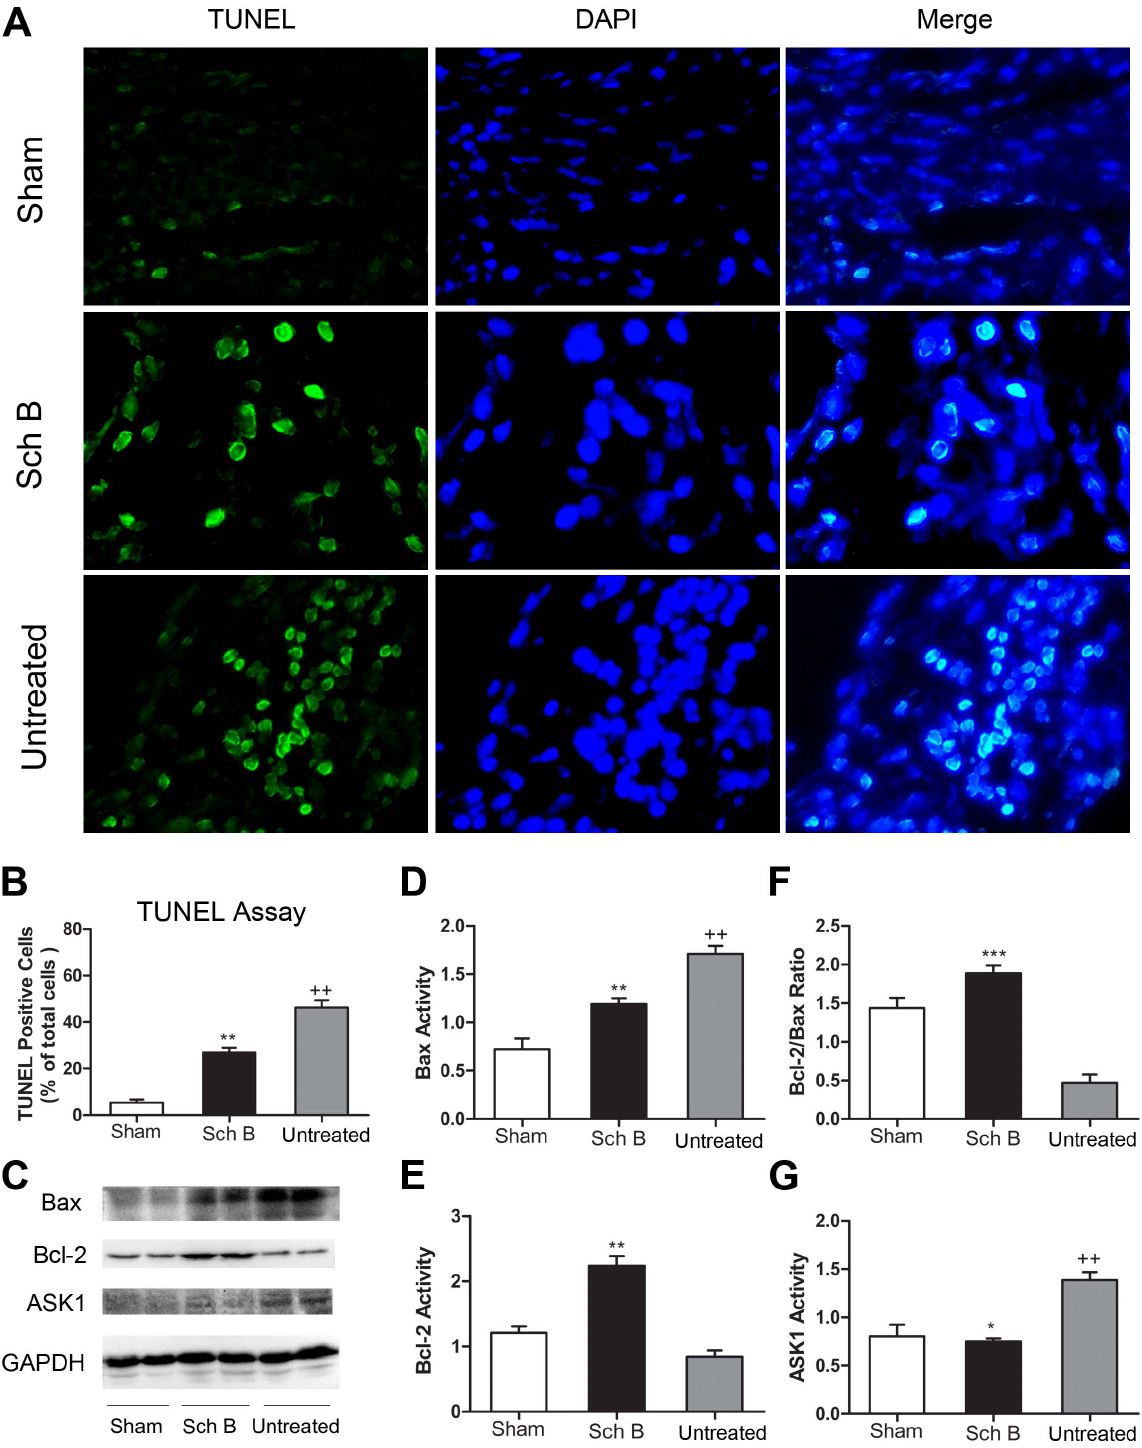
Figure 5. Sch B in the effects of myocardial cell apoptosis. (A) TUNEL analysis of the sham-operated mice, Sch B treated mice and the untreated mice at 3 weeks after MI. The green, TUNEL-positive cells are seen merged with blue DAPI-positive cells at 400 6 magnification. (B) The cardiomyocyte apoptosis index (number of TUNEL-positive cells per 1000 cells) was significantly lower in the Sch B treated group than in the untreated group. (C) Western blotting analysis of Bax, Bcl-2 and ASK1. GAPDH was used as an internal control. (D) Densitometry for Bax expression normalized to GAPDH. (E) Densitometry for Bcl-2 expression normalized to GAPDH. (F) Analysis of the ratio between the expression of Bcl-2 and Bax. (G) Densitometry for ASK1 expression normalized to GAPDH. n=6 per group, * P , 0.05 versus untreated group, ** P , 0.01 versus untreated group, *** P , 0.001 versus untreated group, + P , 0.05 versus sham-operated group, ++ P , 0.01 versus sham-operated group.